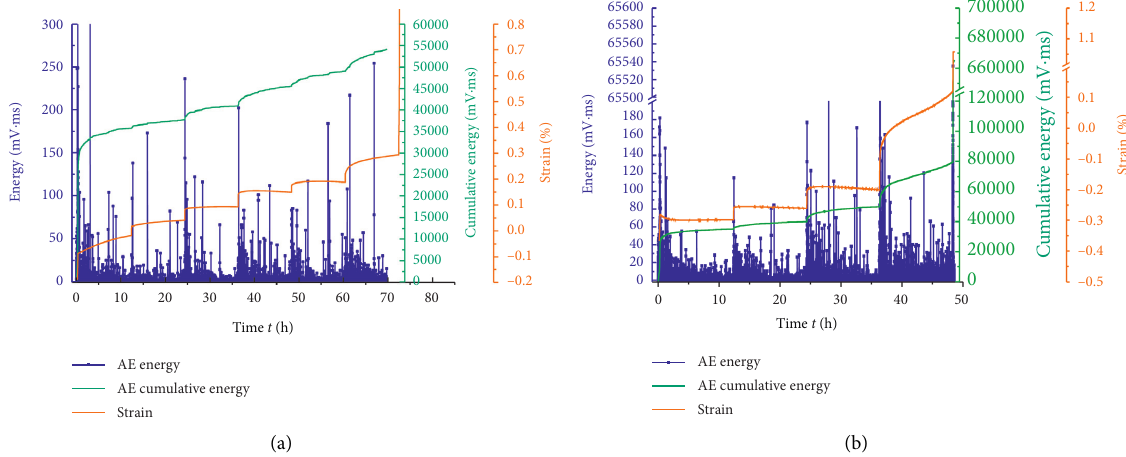
Figure 10: Time-AE energy-cumulative AE energy-strain curve. (a) Scheme 1. (b) Scheme